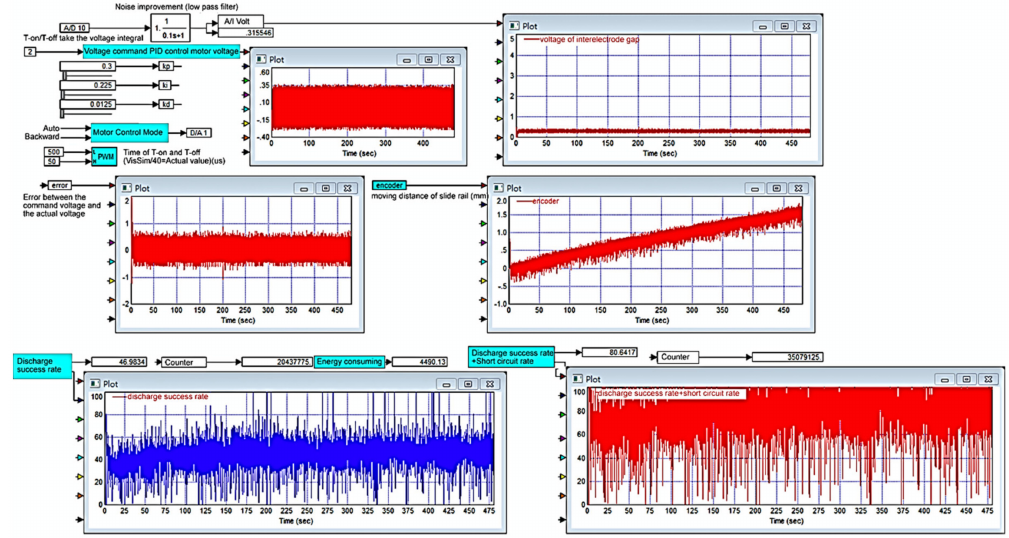
Figure 4. Monitoring interface developed by VisSim